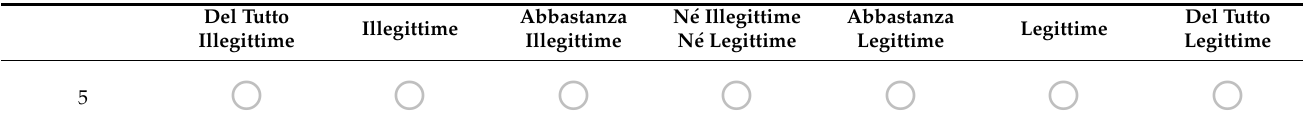
1. Se mi capita di trasgredire le misure restrittive adottate dal governo italiano per fronteggiare l’emergenza del coronavirus, mi rimprovero anche se nessuno ne soffre. 2. Se non agisco in conformità con le misure restrittive adottate dal governo italiano per fronteggiare l’emergenza del coronavirus, mi sento in colpa. 3. Pensando all’emergenza coronavirus, se dovessi provocare un danno a qualcuno mi sentirei in colpa per il male arrecato. 4. Pensando al coronavirus, quando vedo qualcuno che soffre provo pena per lui.